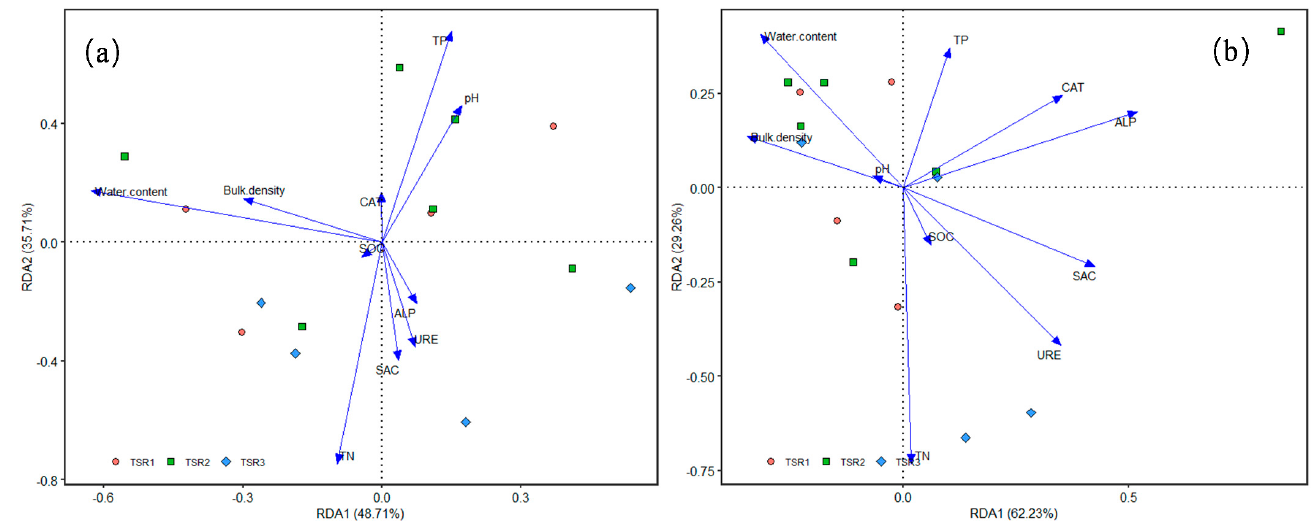
Figure 8. ( a ) Redundancy analysis (RDA) illustrates the relationship between soil fungal trophic modes and environmental variables under tree species combinations. ( b ) Redundancy analysis (RDA) illustrates the relationship between soil fungal functional groups (guild) and environmental variables in tree clusters varying in tree species richness, from one, two, and three tree species combinations in subtropical evergreen broad-leaved forest. SOC: Soil organic carbon, URE: urease, ALP: Acid phosphatase, SAC; Invertase, CAT: Catalase. TSR1: tree species richness 1, TSR2: tree species richness 2, TSR3: tree species richness 3.